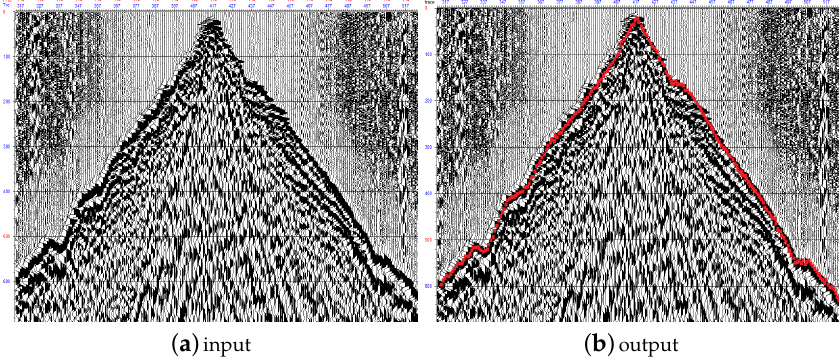
Figure 2. Field data and first-arrival travel